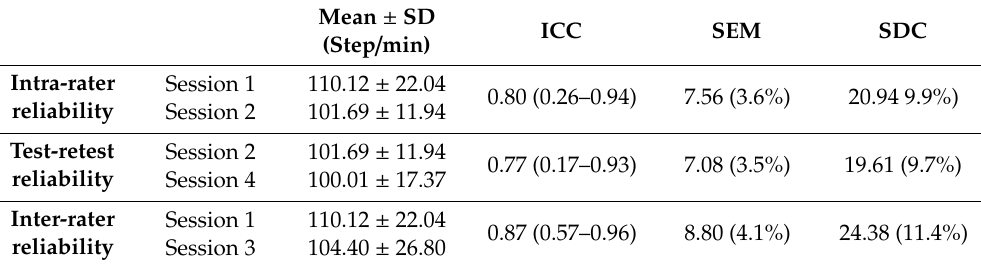
Table 8. Results for gait cadence.